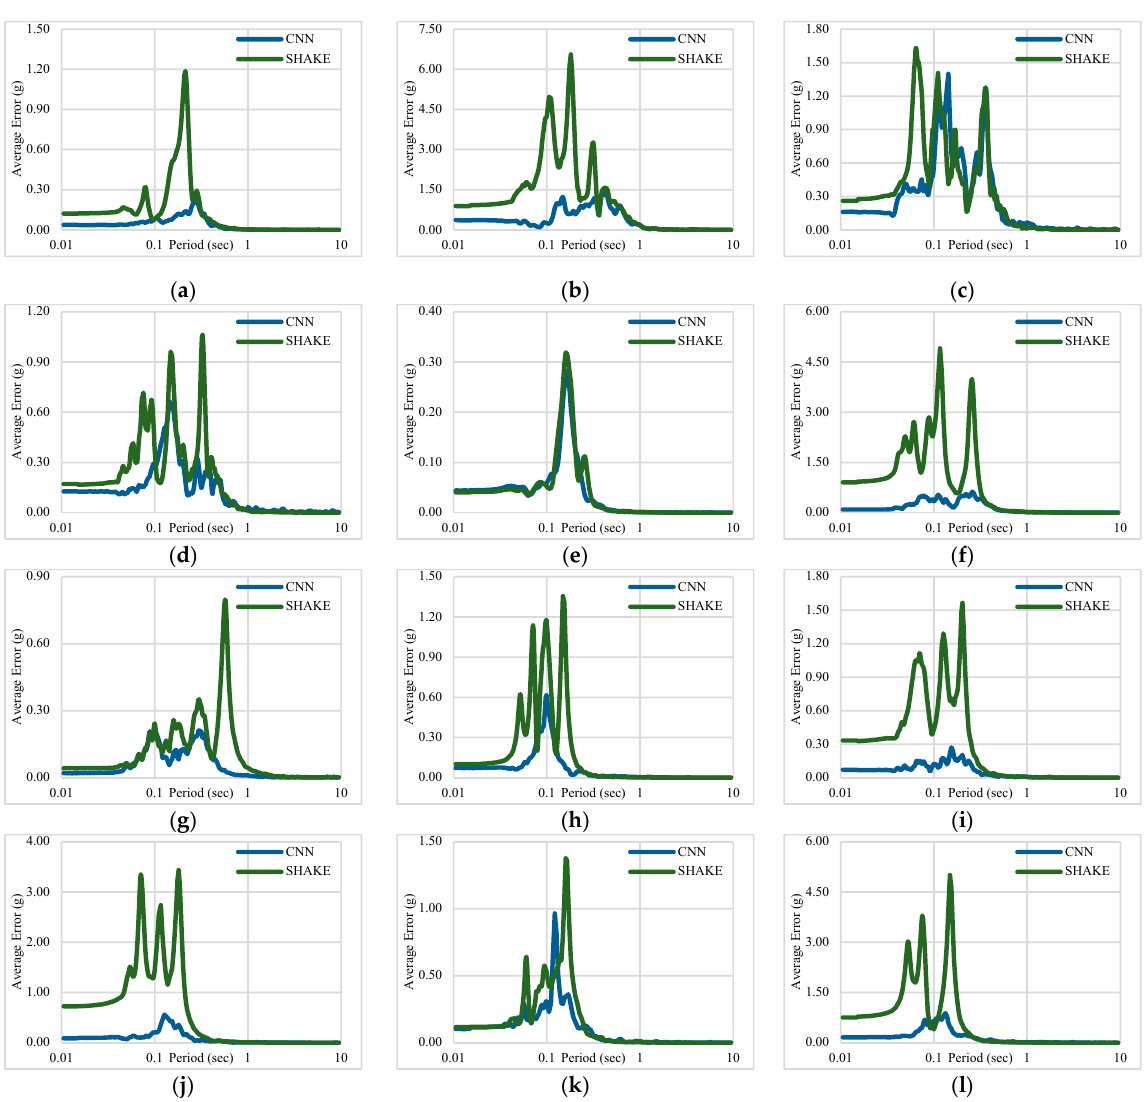
Figure 22. Average errors in the ground motions by the CNN model and SHAKE2000. ( a ) FKSH17 ( b ) FKSH18 ( c ) FKSH19 ( d ) IBRH13 ( e ) IWTH02 ( f ) IWTH05 ( g ) IWTH12 ( h ) IWTH14 ( i ) IWTH21 ( j ) IWTH22 ( k ) IWTH27 ( l ) MYGH04 .